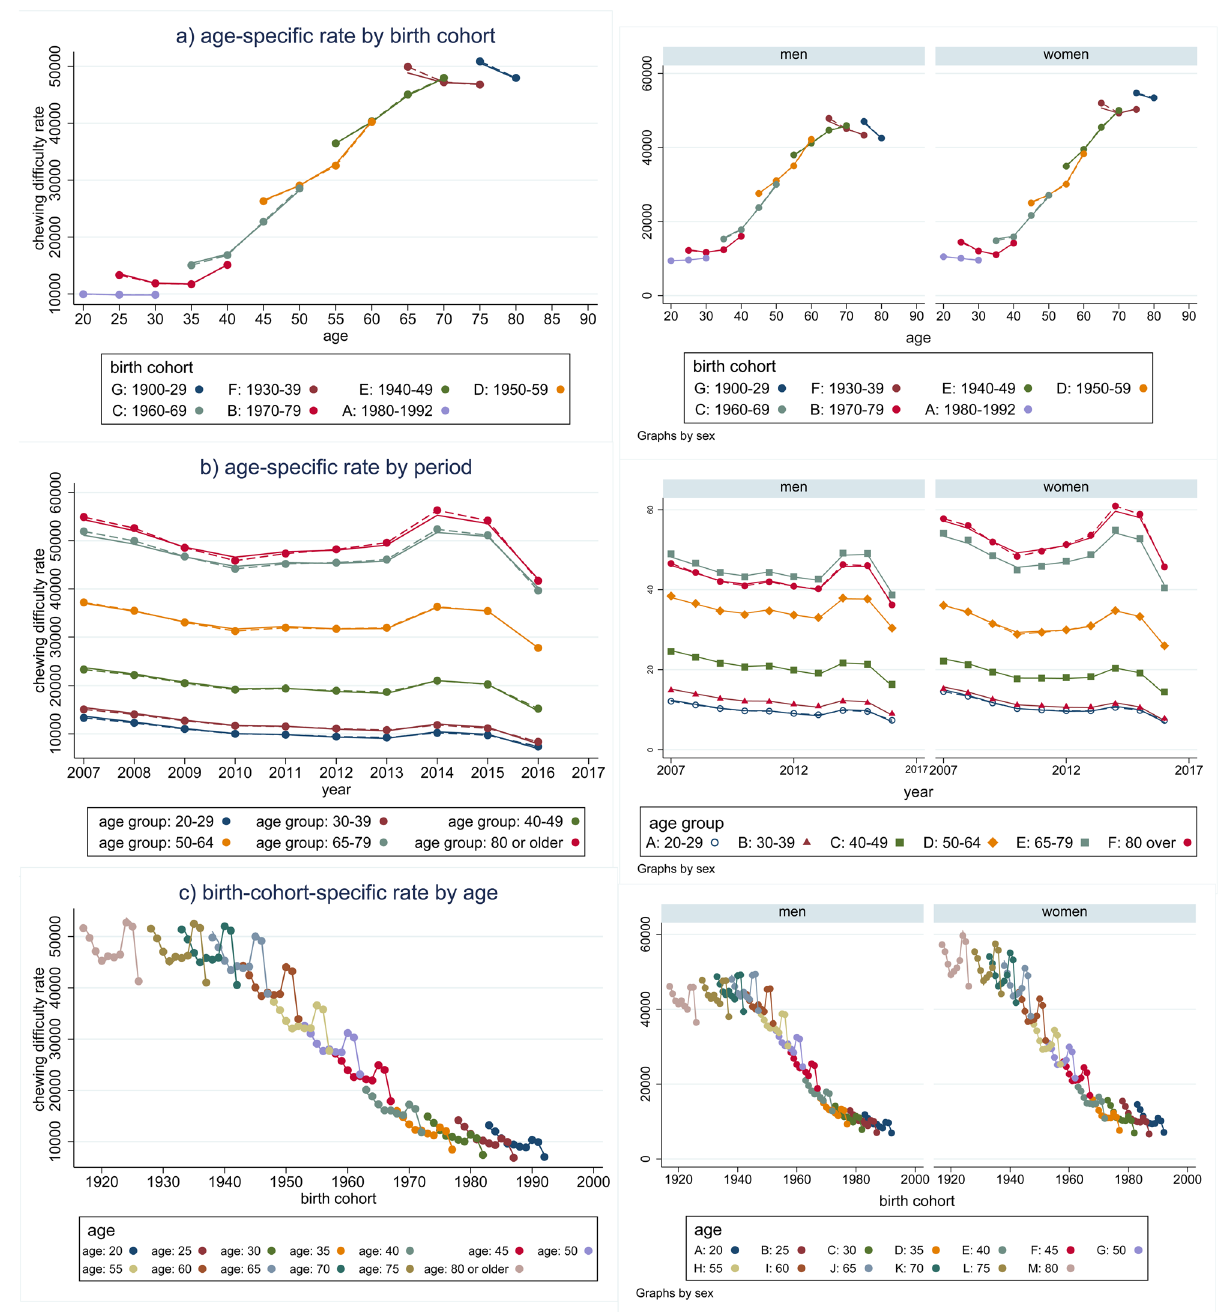
Figure 1. Age, period, and cohort effects on chewing difficulty. Chewing difficulty prevalence between 2007 and 2018 is shown overall, and for men and women: ( a ) age-specific difficulty by birth cohort overall, and for men and women, ( b ) by period overall, and for men and women, ( c ) birth-cohort-specific rate by age overall, and for men and